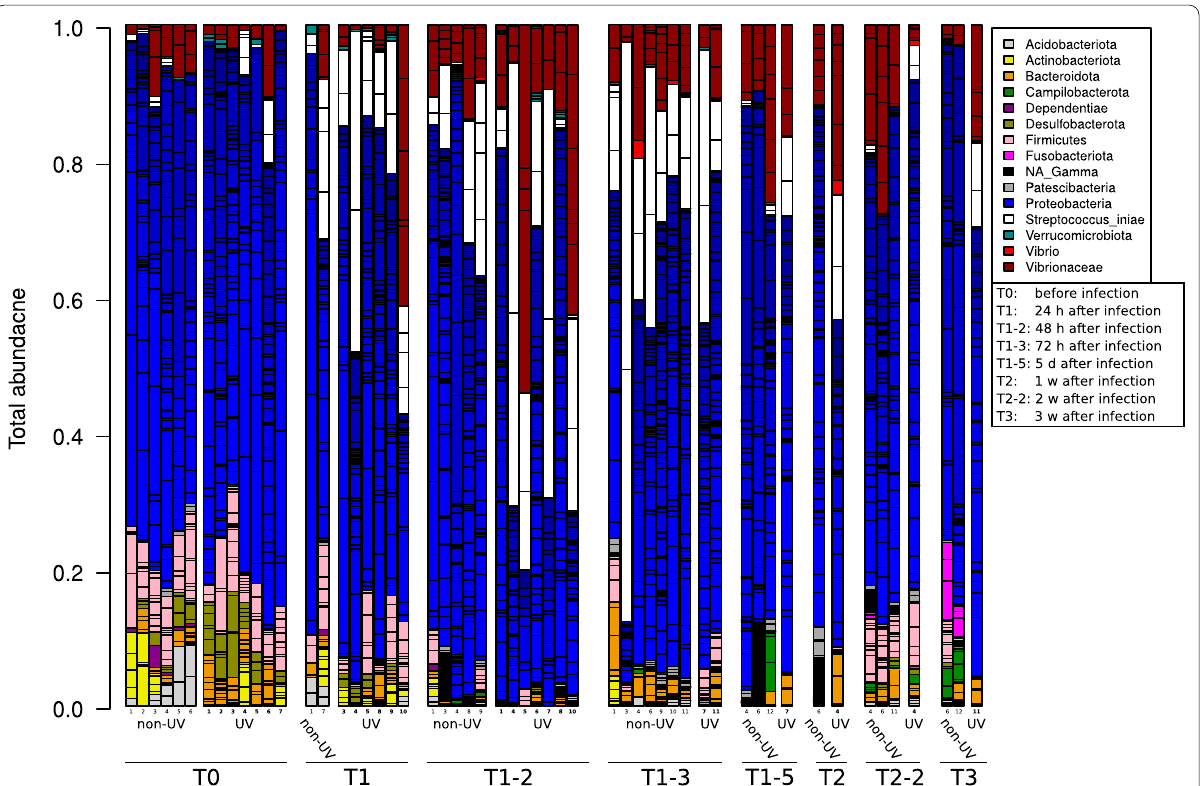
Fig. 7 Bar graph illustrating relative abundances of different bacterial phyla (different colors). Each bar represents one (tagged) fish at different time points (T 0 before infection, T 1 24 h, T 1–2 48 h, T 1–3 72 h, T 1–5 five days, T 2 one week, T 2–2 two weeks and T 3 three weeks post infection), for UV and non‑UV treatments during S. iniae infection in L.